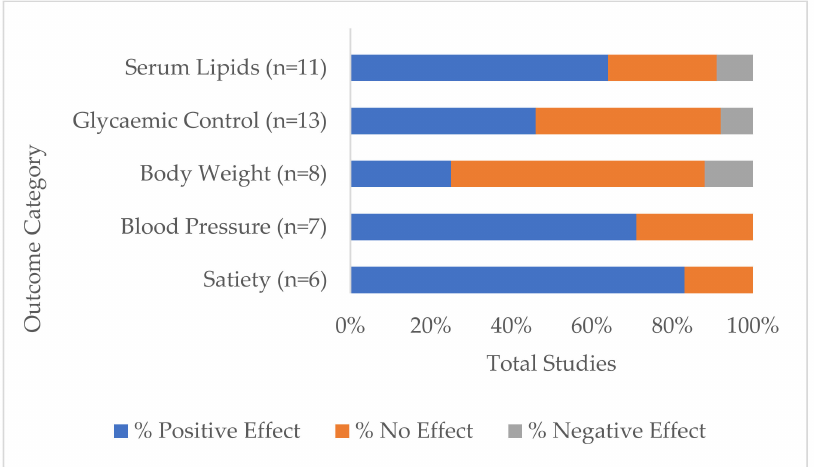
Figure 3. Percentage of total studies that reported differences between baseline and/or comparators ( p < 0.05) by the five most investigated groups of health markers: serum lipids, glycaemic control, body weight, blood pressure and satiety, that had positive (desirable), negative (detrimental) or no effect on health